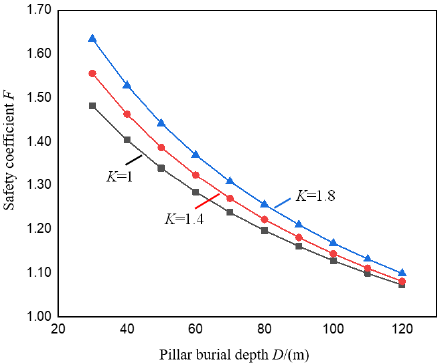
Figure 6. Variation curve of pillar safety coefficient F with pillar burial depth D .